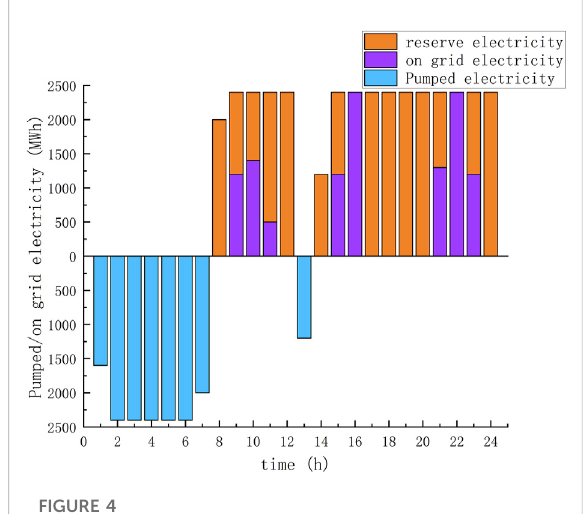
FIGURE 2 OptimaloperationofPSPP thatonlyparticipate intheelectric energy spot market in scenario 1.